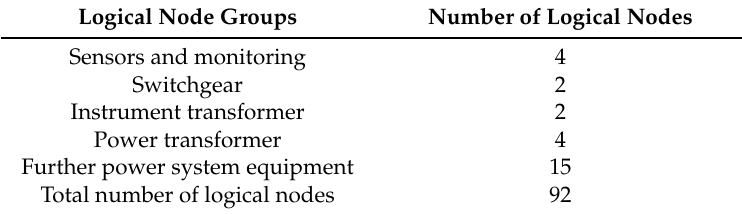
Figure 6. Mapping of the IEC 61850 information model onto OPC UA AddressSpace.